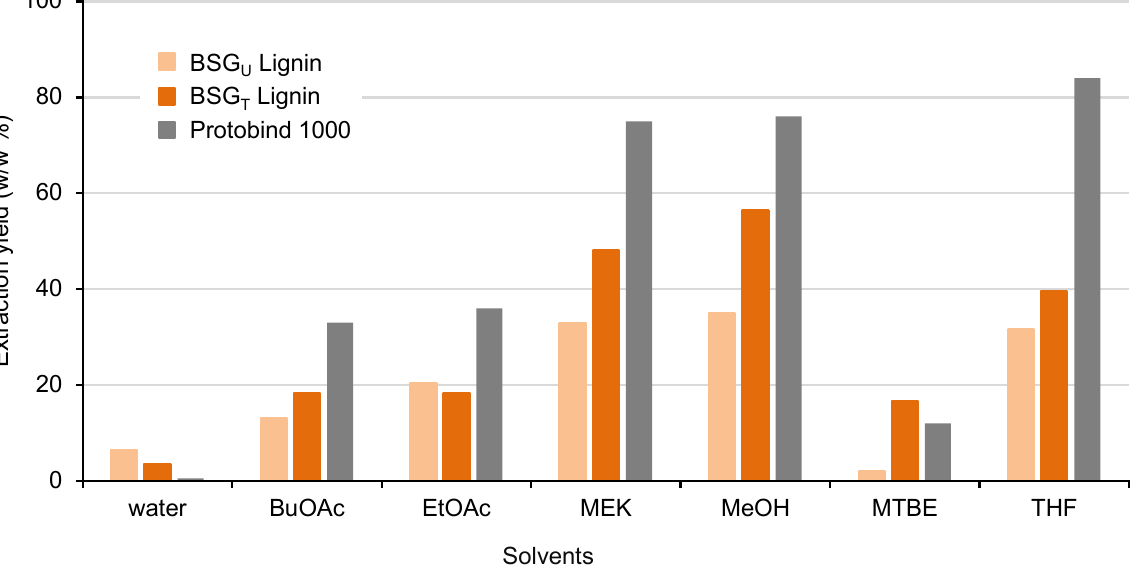
Figure 5. Extraction yield of a commercial technical lignin (Protobind) and the two lignins extracted from BSG (BSG U and BSG T Lignins). The data are reported as the percentage ( w / w ) of solubilized fraction vs. total fraction in 6 different organic solvents and water.